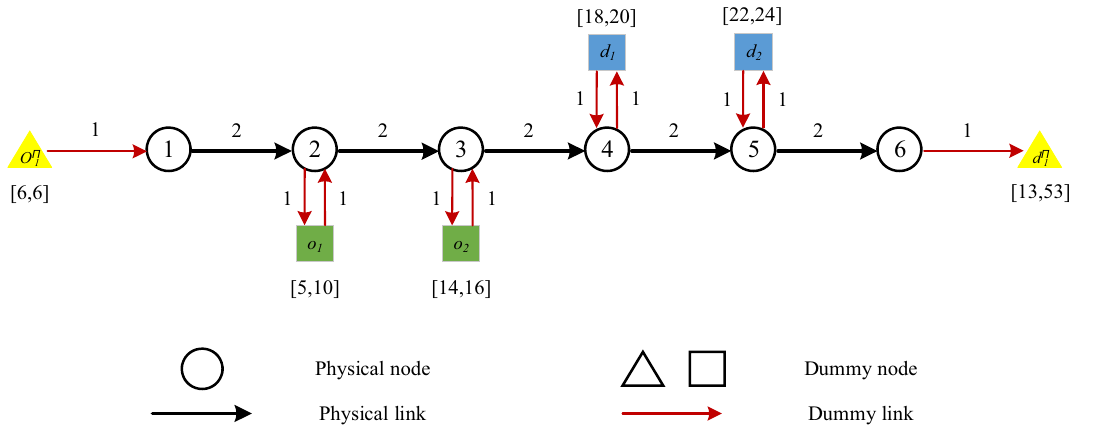
Fig. 13 Network layout and time-window settings for the example with extra passenger waiting time Table 9 The evolution of path node sequences and path time sequences for the example with extra passenger waiting time LR